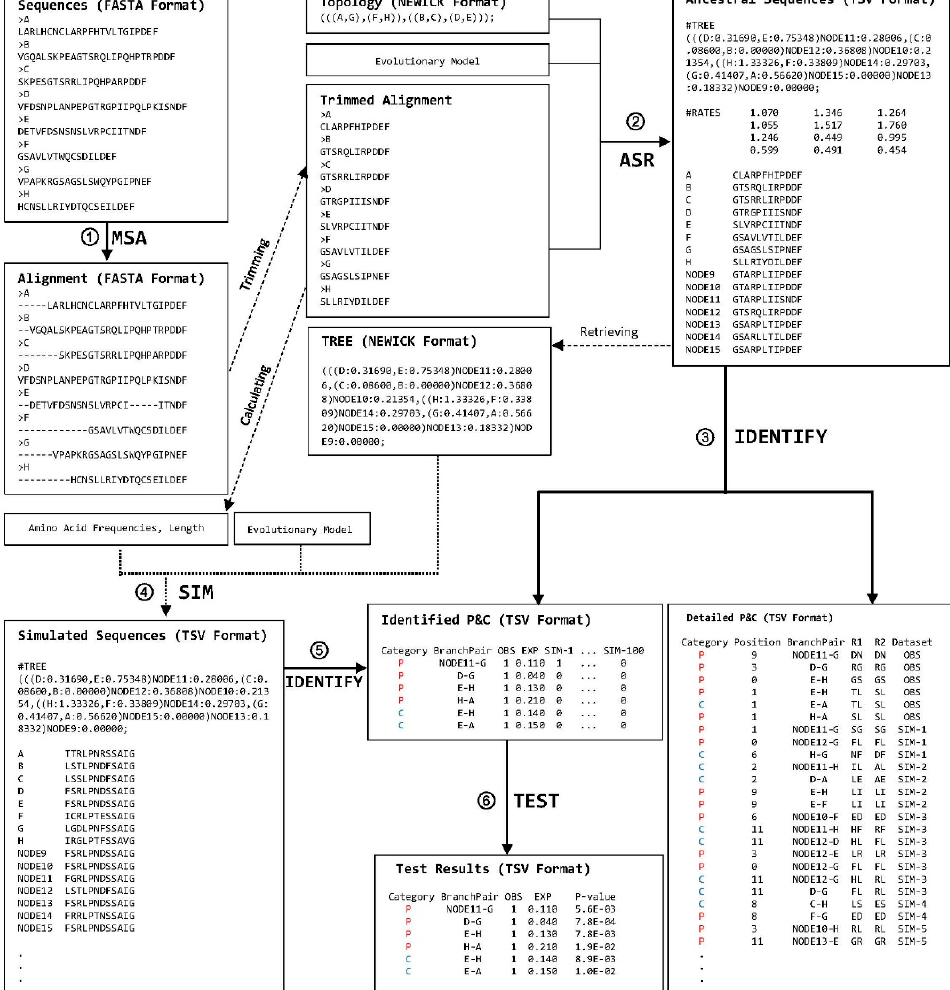
stage or they are directly calculated if no simulation is conducted. The differences between numbers